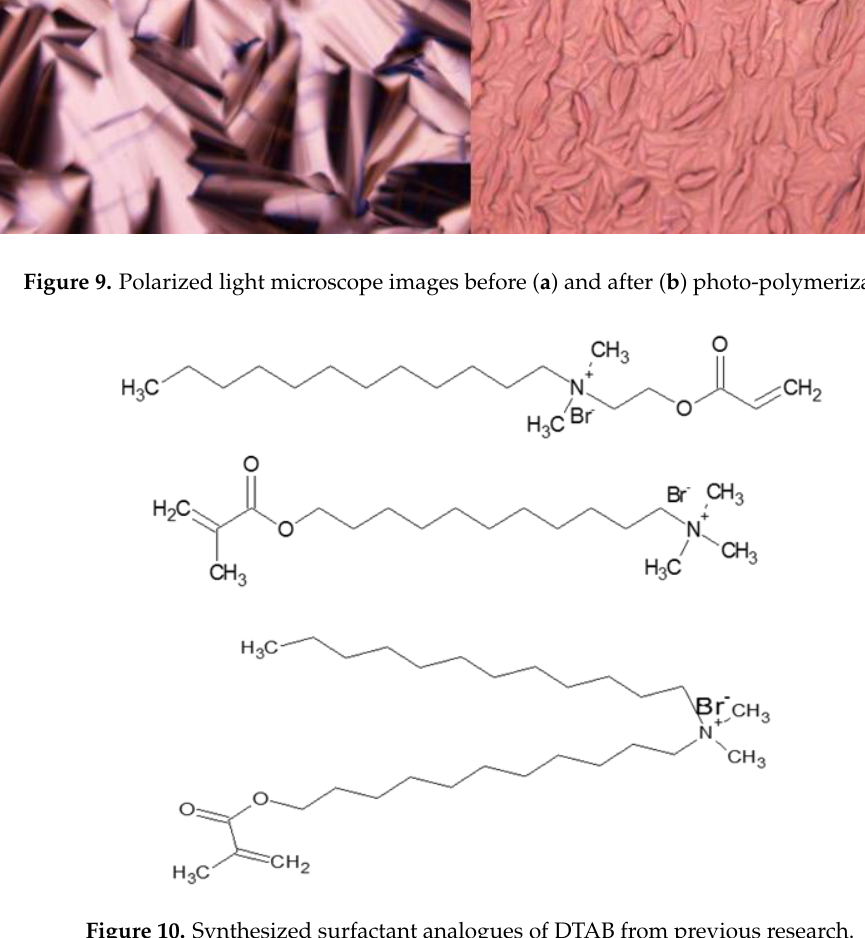
Figure 10. Synthesized surfactant analogues of DTAB from previous research.